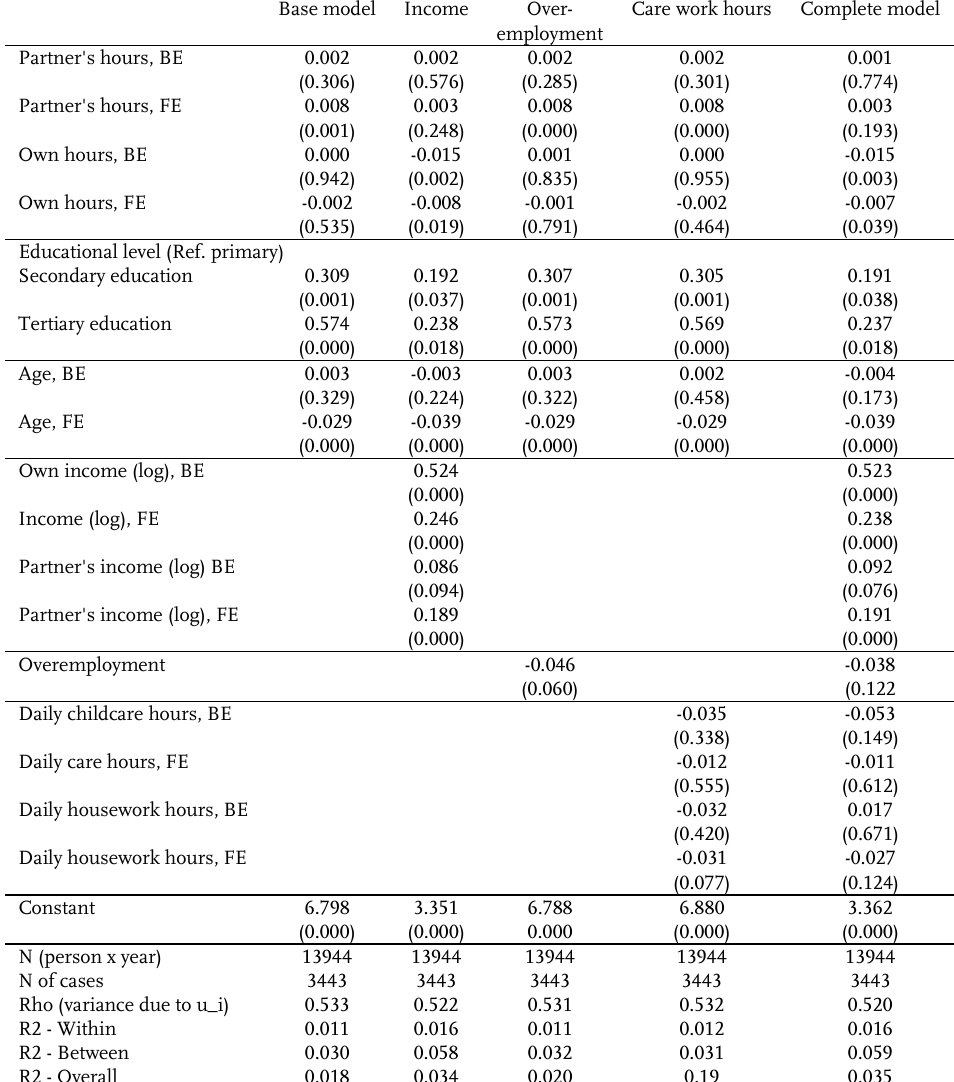
Table A.2 : Estimated coefficients of the hybrid model: Men without children < 14 in the household; p values in parentheses Base model Income Over- Care work employment